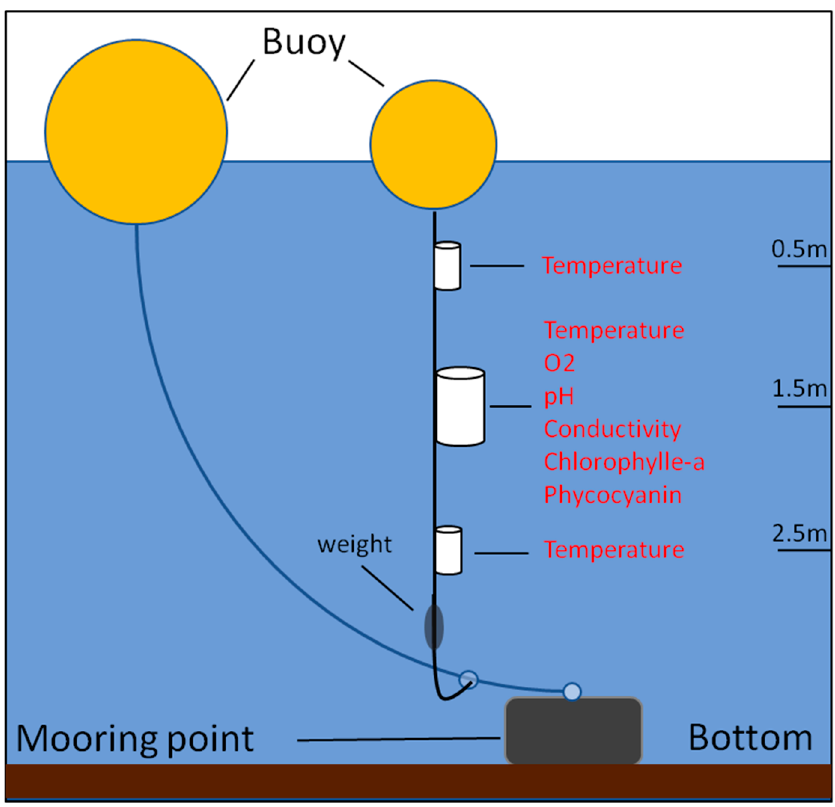
Figure 2. The monitoring design at the point B.